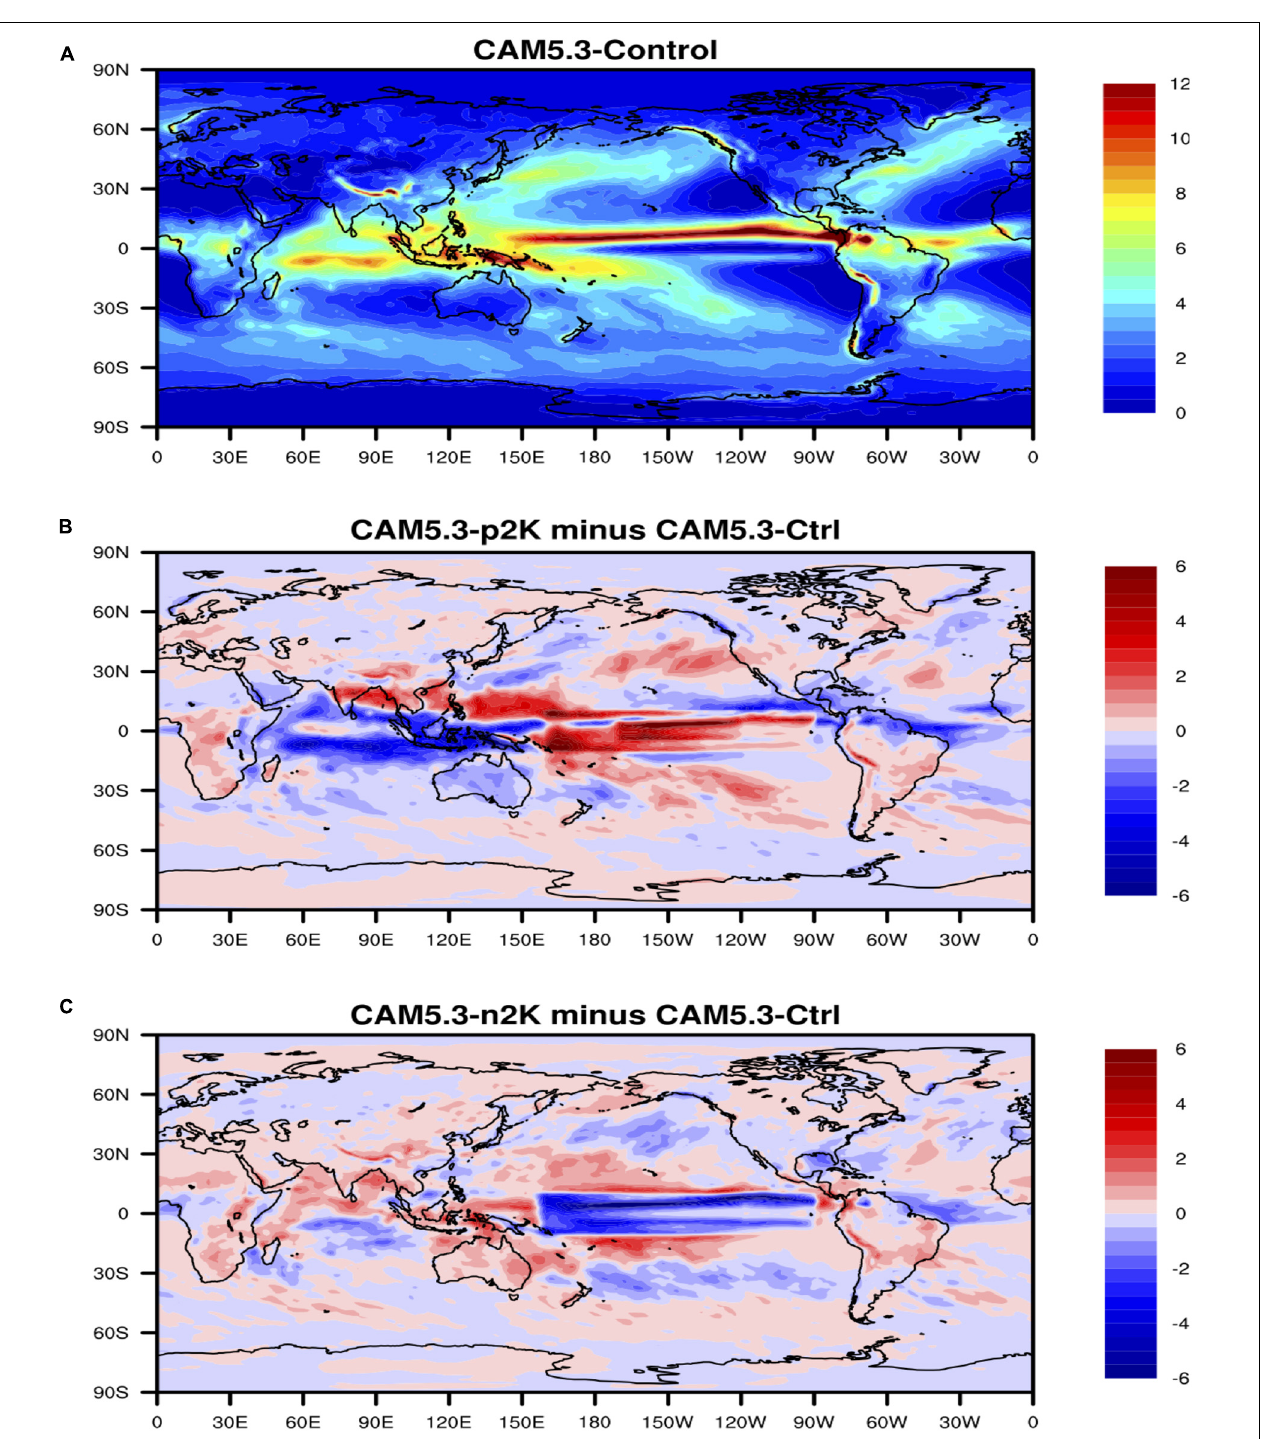
FIGURE 11 | (A) Surface precipitation in the CAM5 control run. (B) Anomalies of precipitation in the CAM5 + 2K run with respect to the control run. (C) Anomalies of precipitation in the CAM5-2K run with respect to the control run. Unit of precipitation is mm/day.